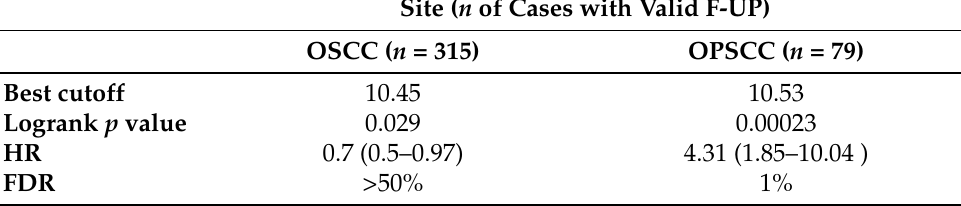
Table 6. Analysis of NRP-1 gene expression in the TCGA Head and Neck dataset. The best p value cutoff for thresholding is shown. Significance at <0.05. (HR: Hazard Ratio; FDR: False Discovery